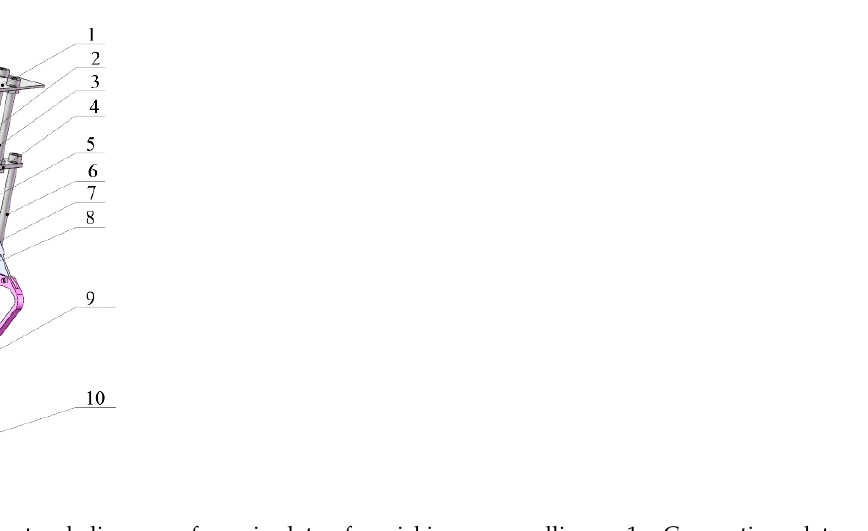
Figure 3. Structural diagram of manipulator for picking up seedlings. 1. Connecting plate. 2. Pneumatic cylinder. 3. Upper connection screw. 4. Cylinder fixing plate. 5. Intermediate moving block. 6. Lower connection screw. 7. Connecting rod. 8. Bottom rack. 9. Gripper finger for picking up seedlings. 10. Plug seedling.